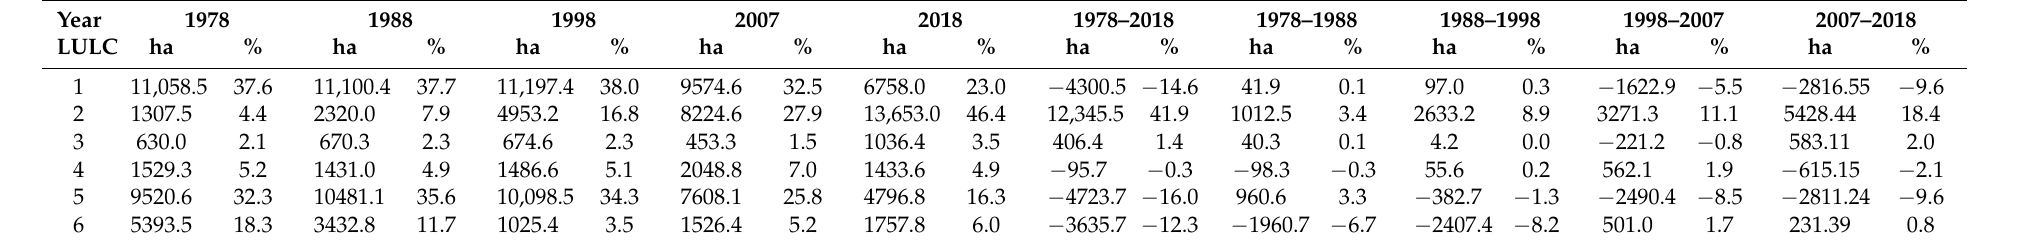
Table 8. Decadal LULC classes area (ha) and percentage (%) distribution along with change matrix for the Dhaka city